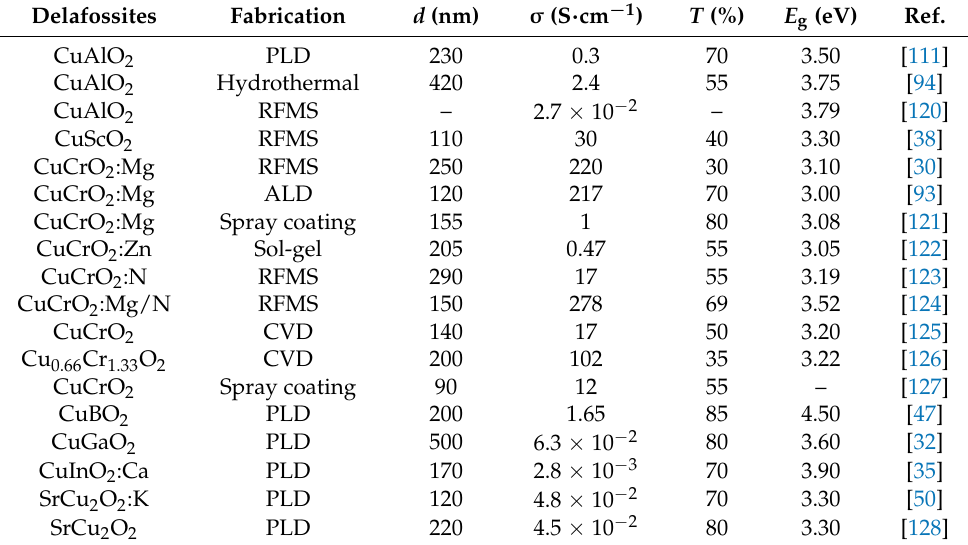
Table 1. Summary of selected delafossites with their material properties including thickness ( d ), conductivity ( σ ), transmittance ( T ), and optical band gap ( E g ). ALD: atomic layer deposition,